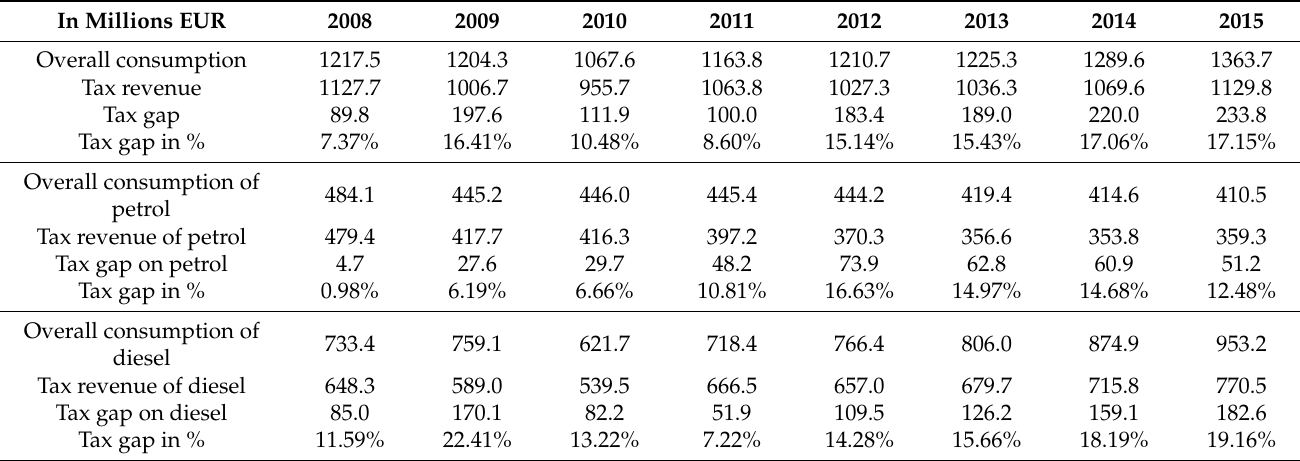
Table 1. The tax gap in % of the overall consumption and in EUR million classified into diesel and petrol—low risk rate. In Millions